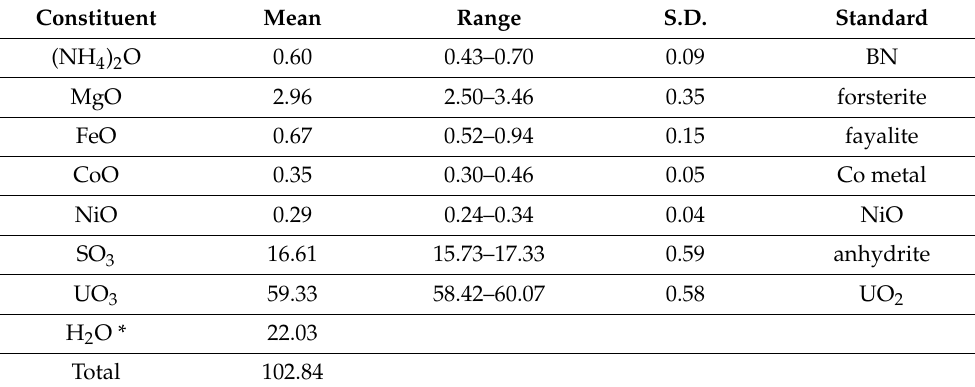
Table 1. Chemical composition (wt%) for chenowethite based on one analysis. Constituent Mean Range S.D.